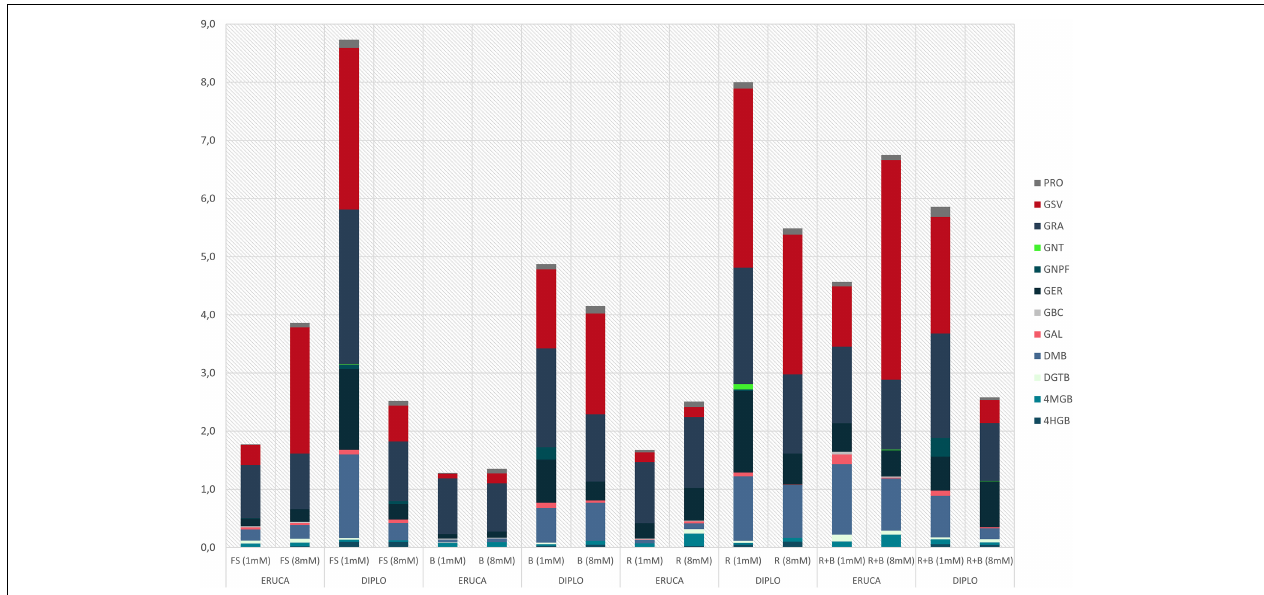
FIGURE 4 | GLSs content of rocket leaves ( E. sativa and D. tenuifolia ) in function of light and N level. (ERUCA, E. sativa ; D, D. tenuifolia ); 1 and 8 mM, nitrogen level into the nutrient solution; FS, full spectrum; B, BLUE, peak at 460 nm; R, RED, peak at 660 nm; R + B, RED + BLUE, 75% red + 25% blue. 4HGB, 4-hydroxyglucobrassicin; 4MGB, 4-methoxyglucobrassicin; GBC, glucobrassicin; DMB, dimeric-glucosativin; GER, glucoerucin; GNPF, gluconapoleiferin; GRA, glucoraphanin; GSV, glucosativin; DGTB, diglucothiobeinin; PRO, progoitrin; GAL, glucoalyssin; GNT,